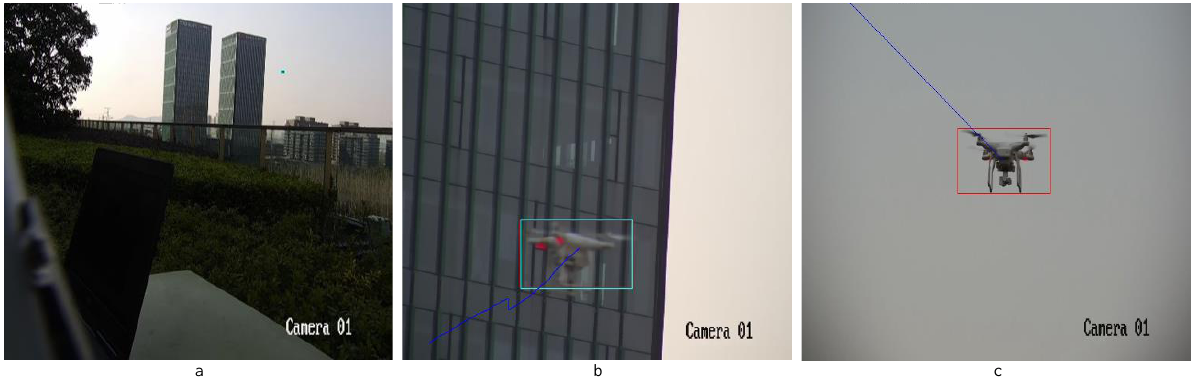
Figure 14. Detection and tracking results for the proposed method: ( a ) Detection and tracking result for a small drone; ( b ) illustration of detection, tracking, and direction of the target; and ( c ) illustration of tracking and direction of the target. The direction shows the state shift of the drone from the previous state to the current state. The teal color indicates the detection result, red indicates the tracking state, and black indicates the turret rotation